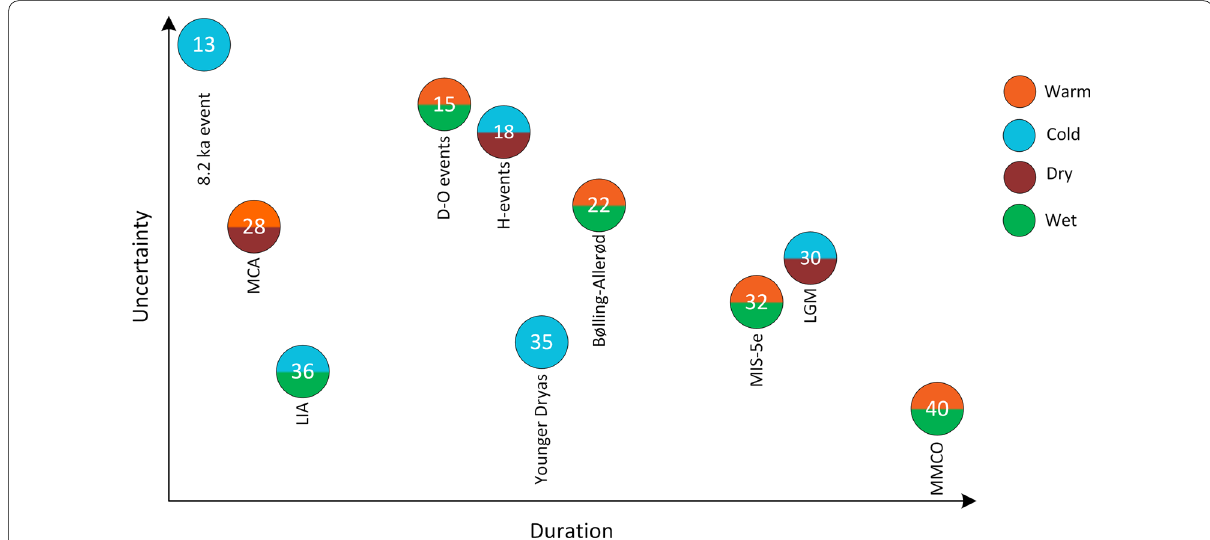
Fig. 10 Schematic representation of hydroclimatic conditions in terms of the period length and the uncertainty involved. Uncertainty is qualitatively derived from the number of